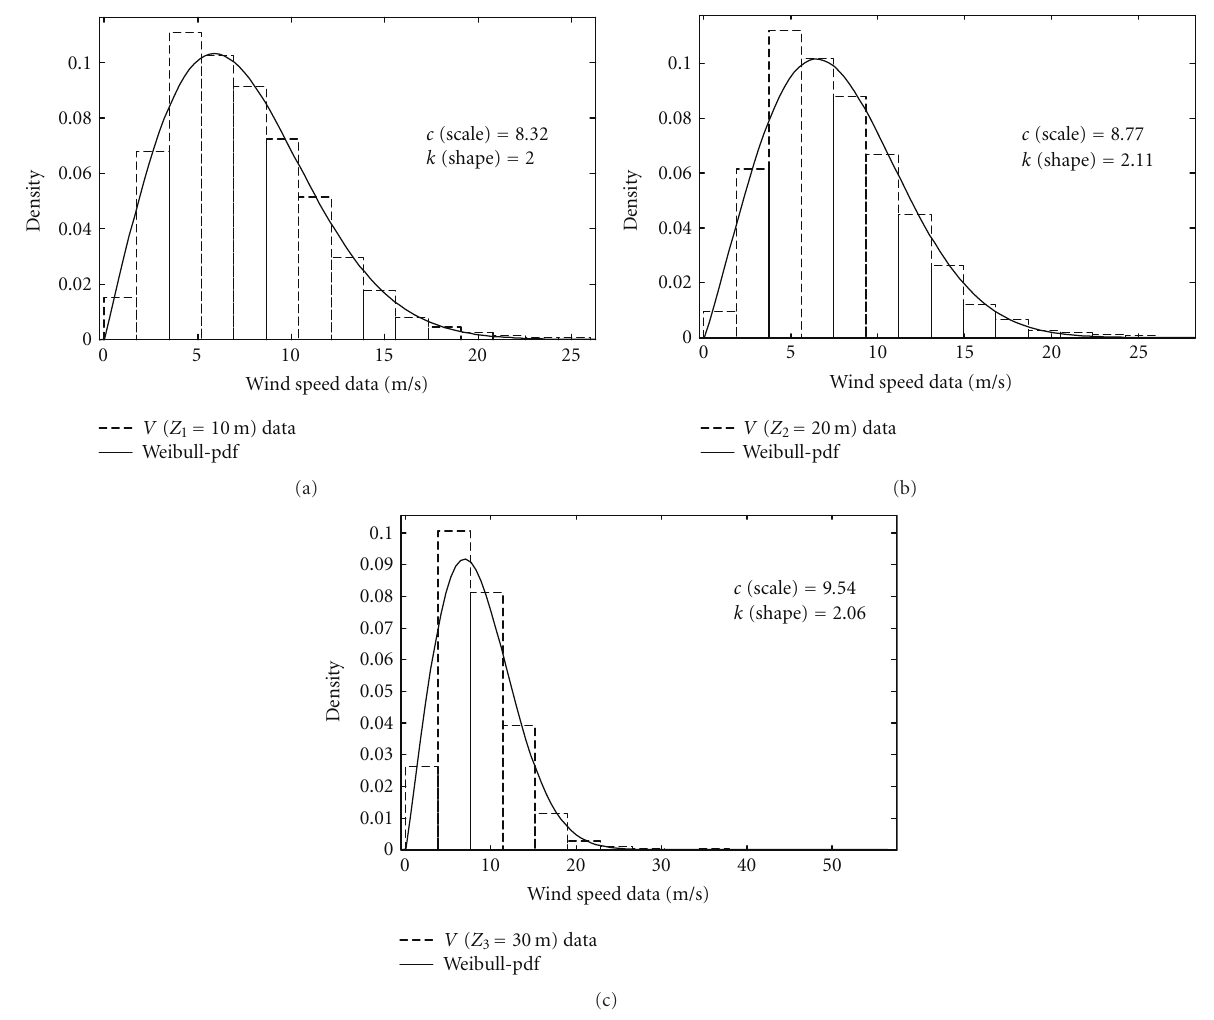
Figure 3: Karaburun Weibull pdf’s at di ff erent levels. Table 2: Wind speed summary statistics of Karaburun for three di ff erent heights.